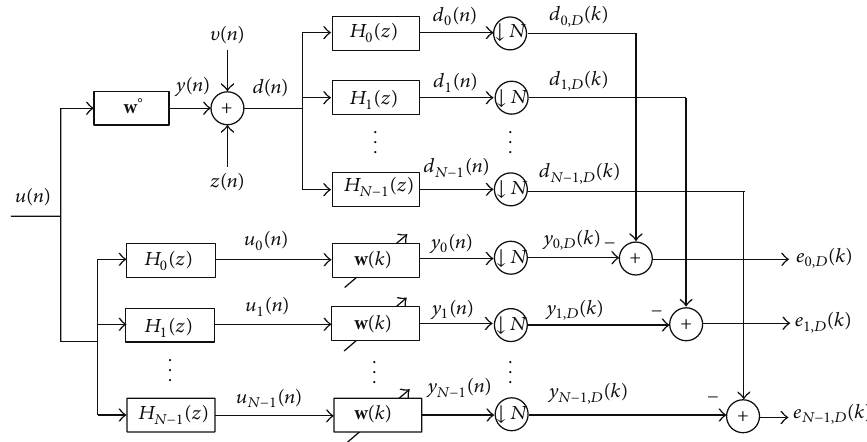
Figure 1: Subband structure used in the proposed